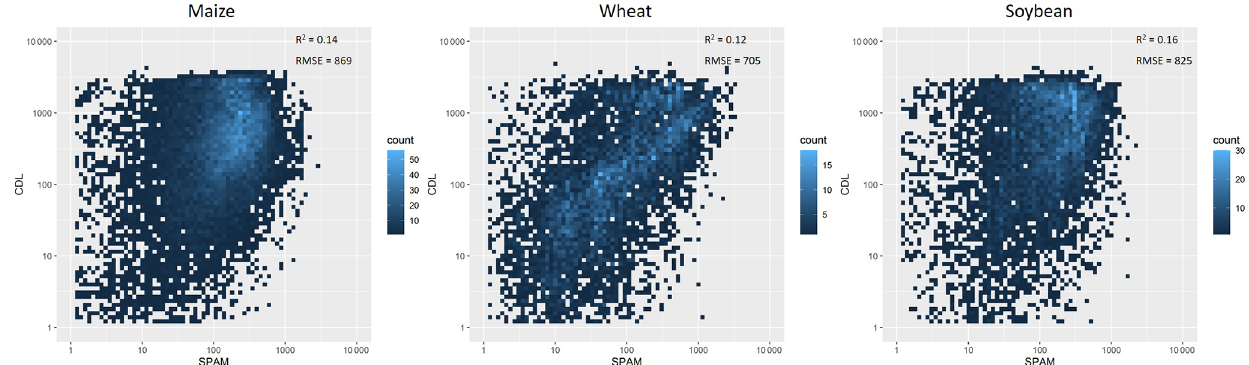
Figure 14. Comparison between SPAM crop area change and CDL crop area change (log–log scale plot; unit: